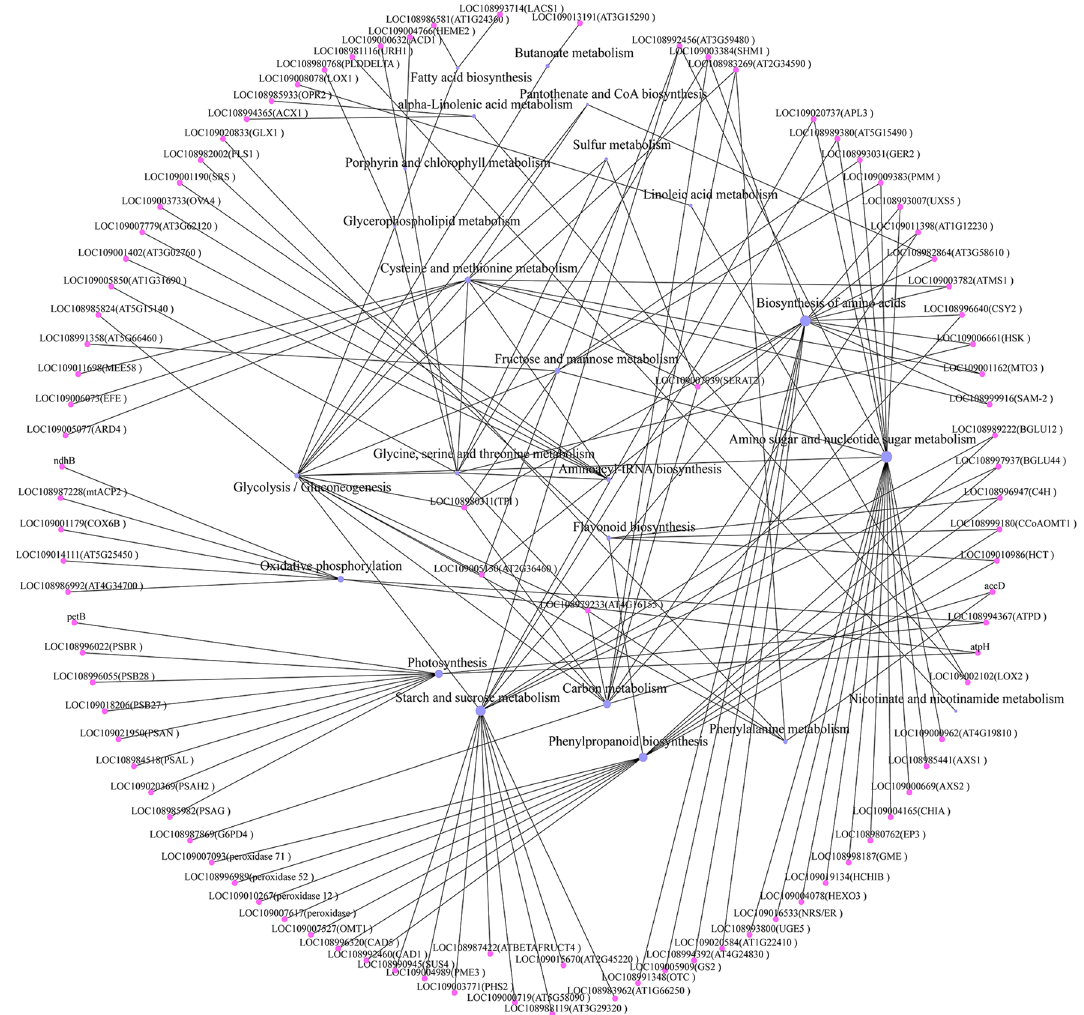
Figure 5. A summary of differentially expressed proteins related to the response of leaves to salt stress and the KEGG pathways involved. The protein is represented by a pink circle; the KEGG pathway it participates in is represented by a blue circle. The size of the blue circle represents the number of proteins involved in its